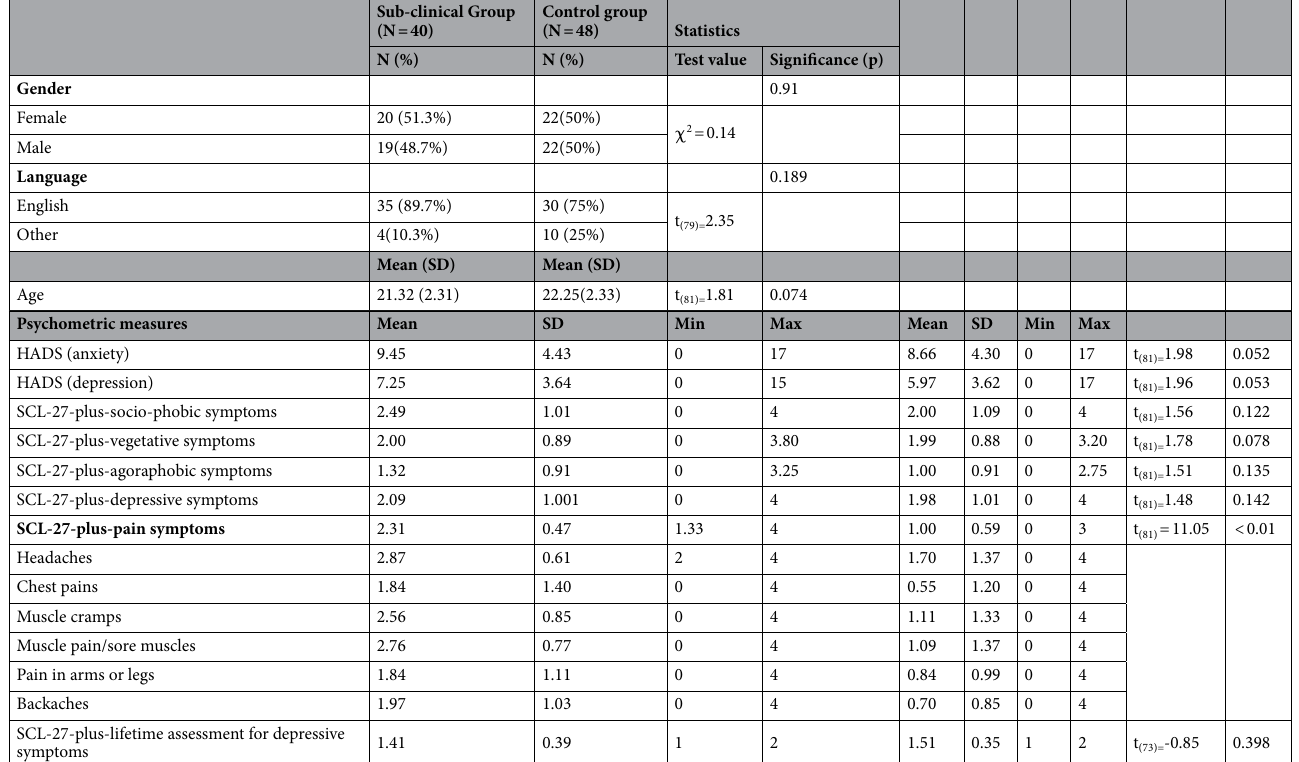
Table 1. Participants’ sociodemographic characteristics and clinical scores (N = 88). This table demonstrates participants’ sociodemographic characteristics and the clinical scores of both groups on different psychometric measures used in the study. SCL‑27‑plus Symptom Checklist, HADS Hospital Anxiety and Depression Scale, Sub‑Clinical Group participants with clinically significant pain symptoms, Control Group participants without clinically significant pain